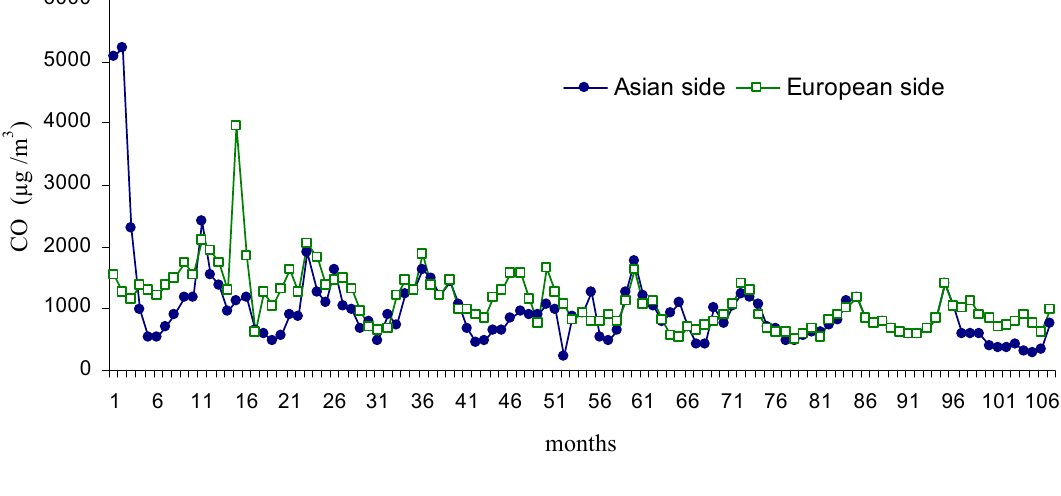
Figure 3. Monthly changes of CO (µg/m 3 ) during the study period (Jan 2002–Dec